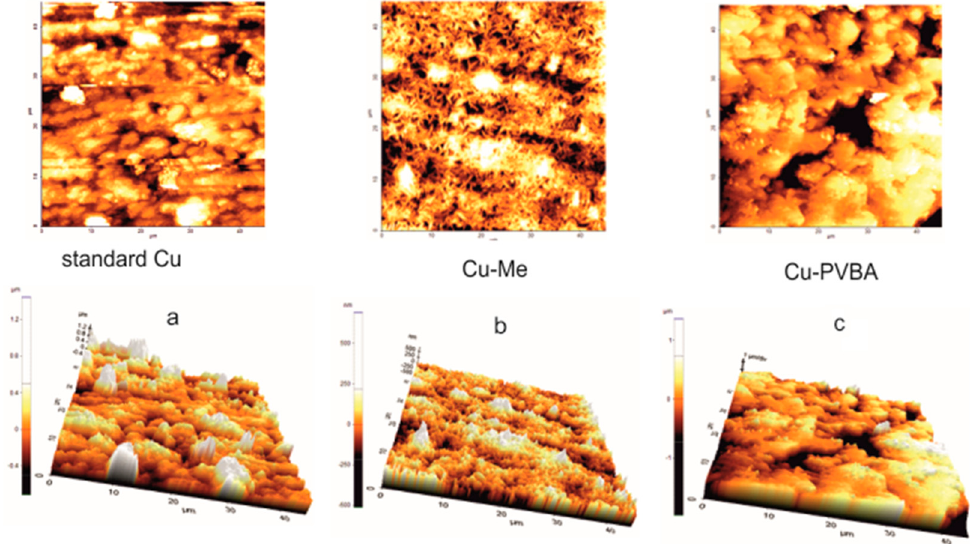
Figure 6. Atomic Force Microscopy (AFM) 2D and 3D images obtained for copper surface after corrosion: ( a ) Standard copper; ( b ) copper immersed in methanol (Cu-Me sample); ( c ) copper immersed in methanol containing PVBA (Cu-PVBA sample).